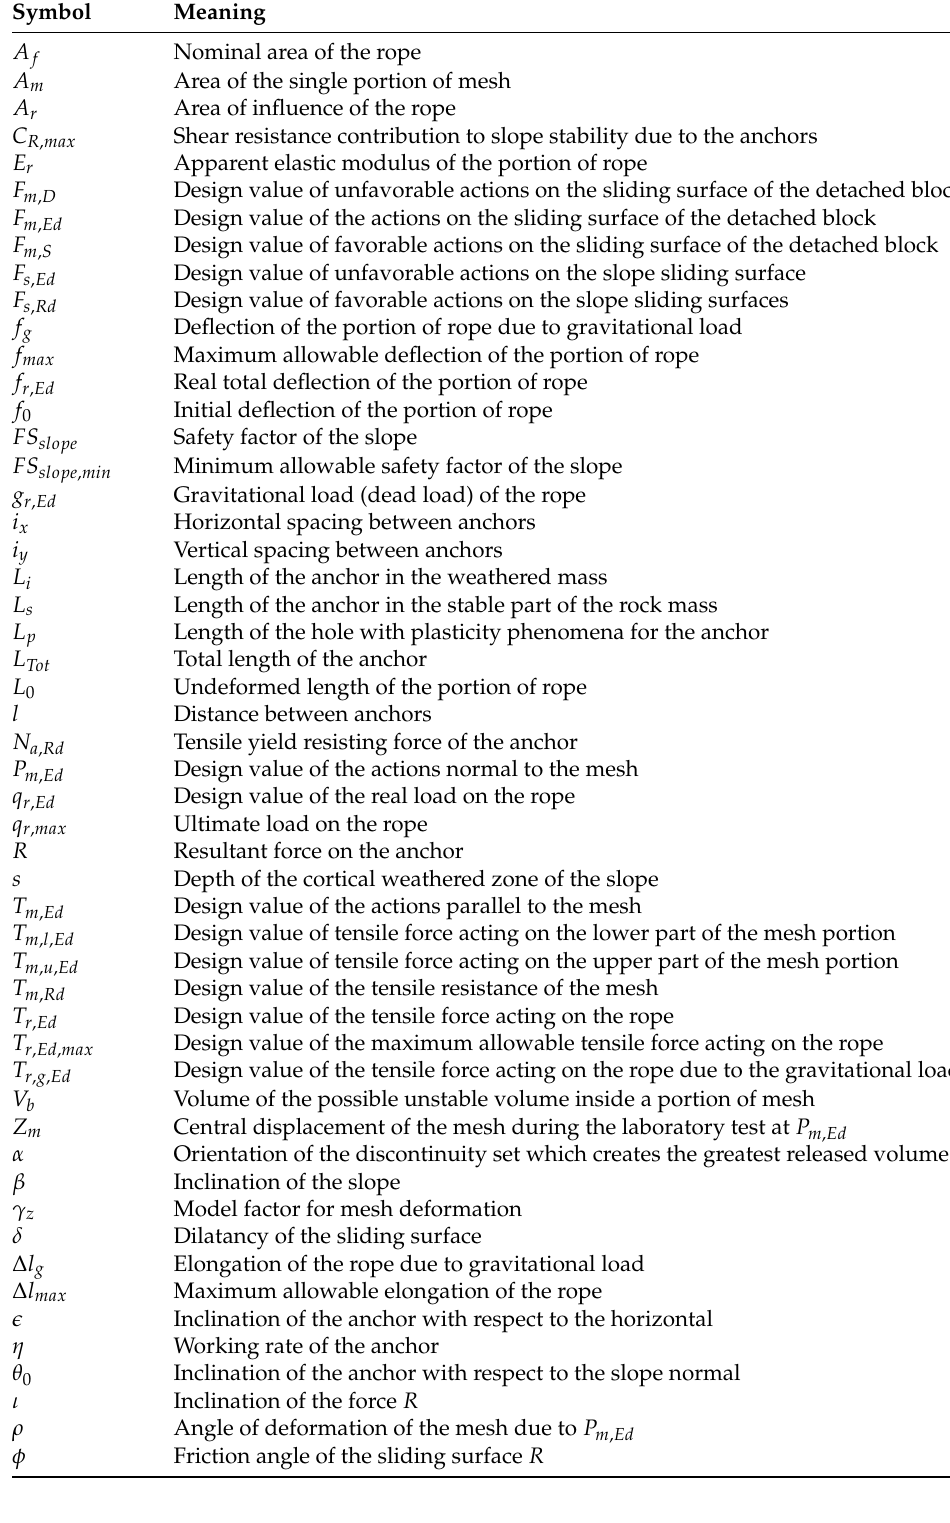
Table 1. List of the mathematical symbols used in this work and their